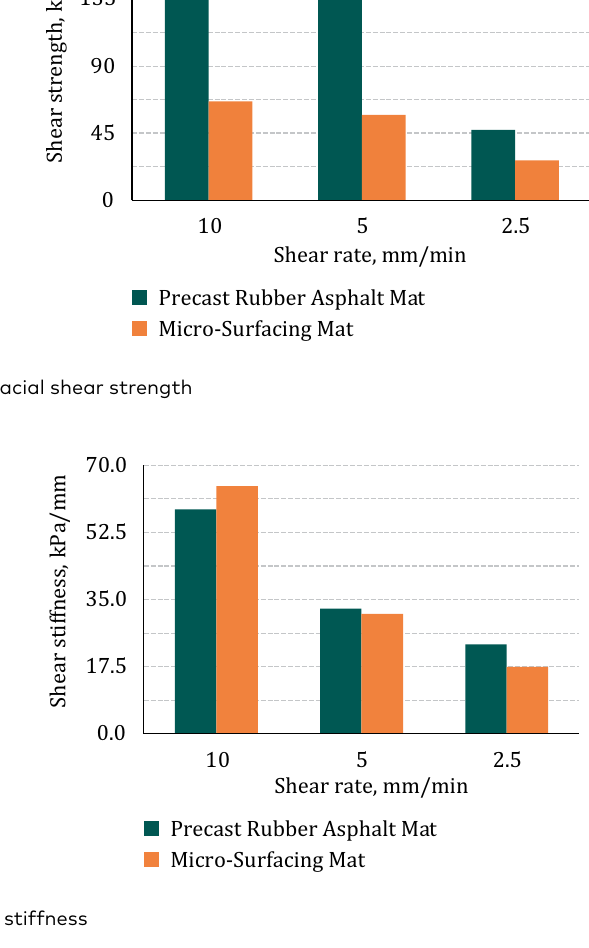
Figure 9. Shear strength and stiffness under various shear